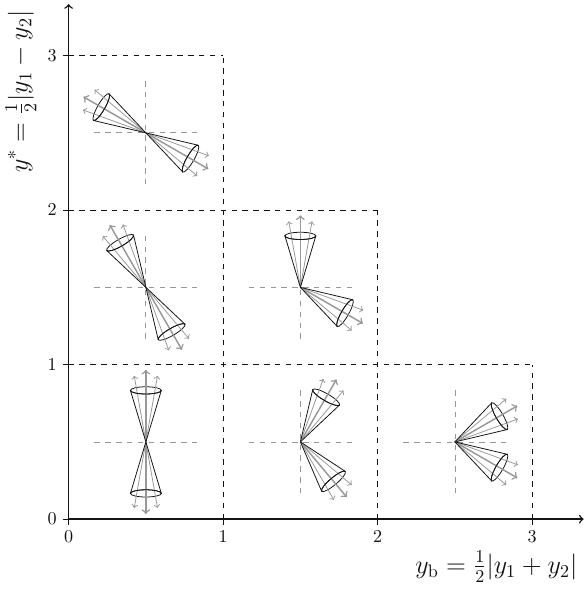
Fig. 1 Illustration of the dijet event topologies in the y ∗ and y b kine- matic plane. The dijet system can be classified as a same-side or opposite-side jet event according to the boost y b of the two leading jets, thereby providing insight into the parton